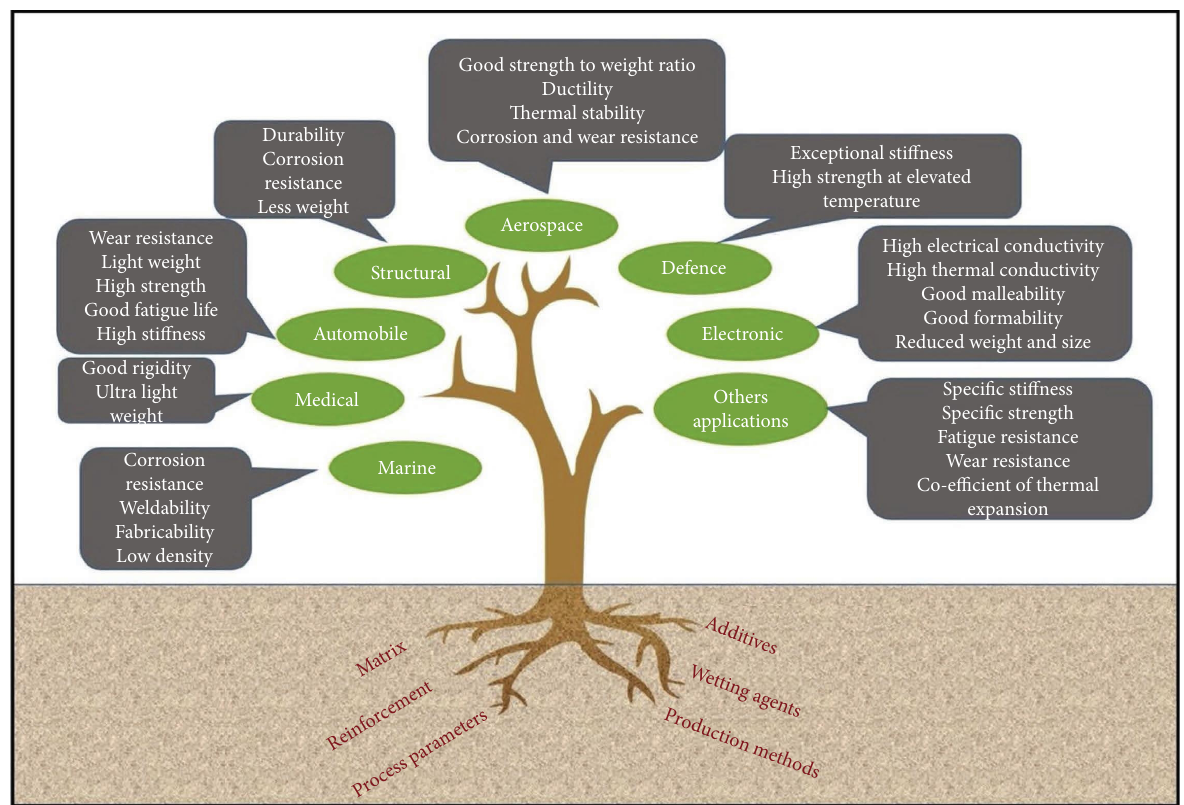
Figure 22: Applications of MMCs and HMMCs in various fields, reproduced with permission from Ref. [7], copyright 2019,